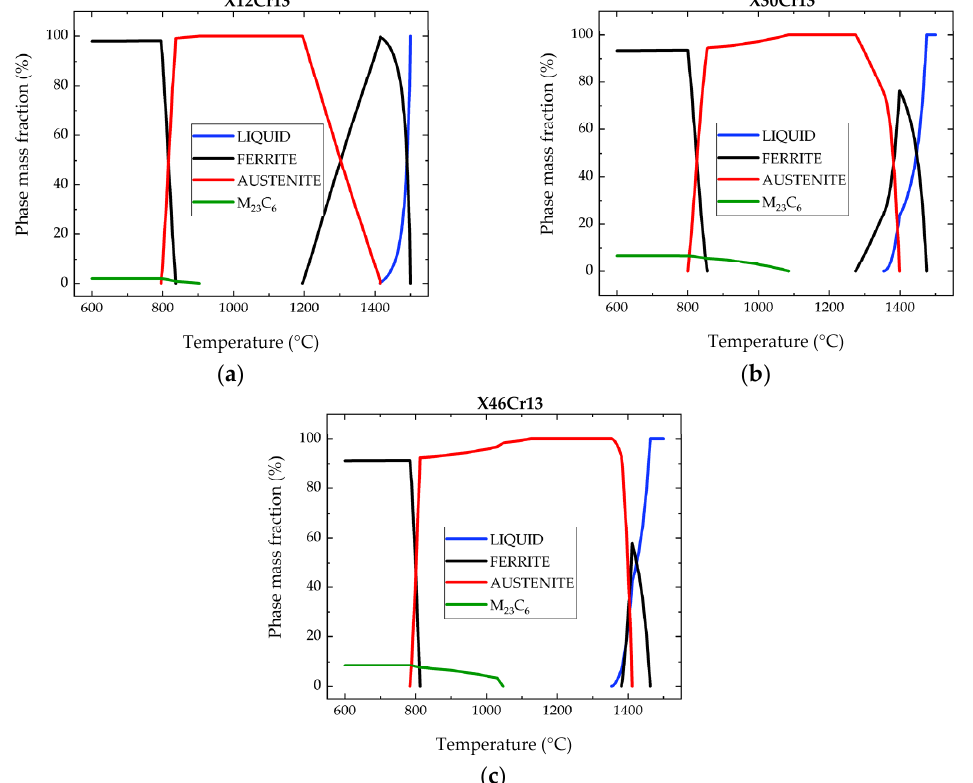
Figure 5. Phase mass fraction diagrams as function of the temperature for the X12Cr13 ( a ), X13Cr13 ( b ), and X46Cr13 ( c ) alloys.